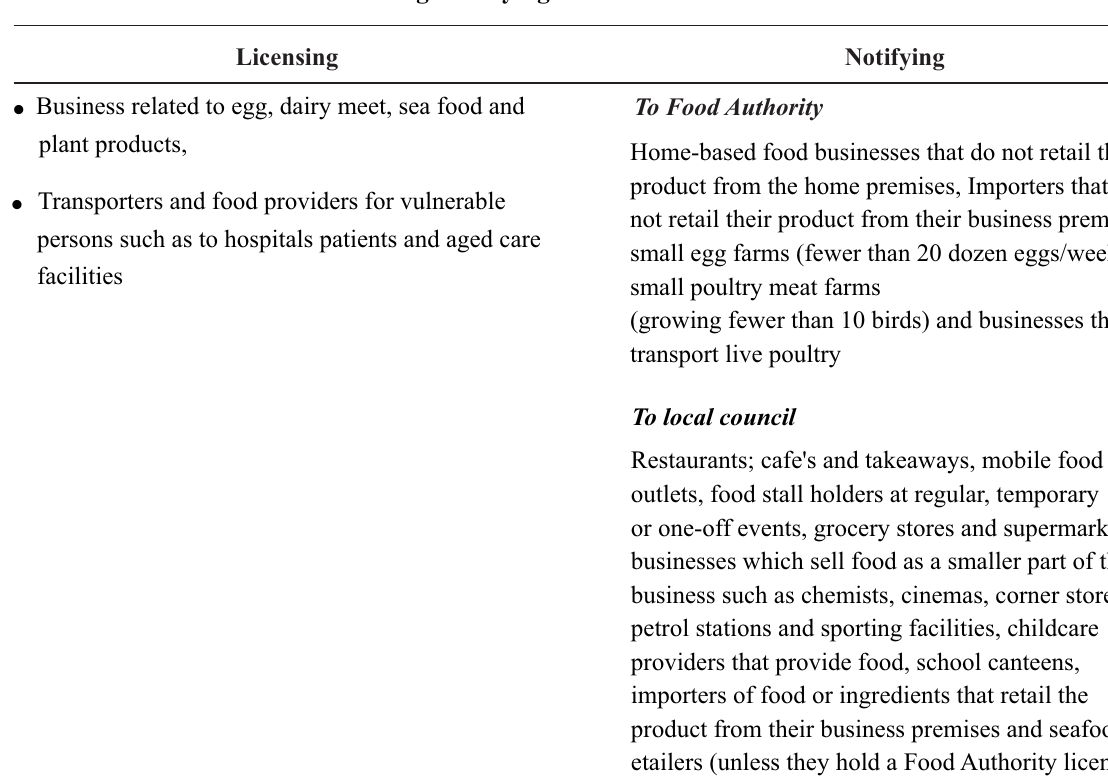
Table 2: Food business need licensing / notifying in Australia